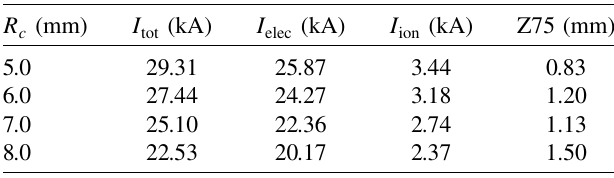
TABLE I. CRAD diode performance as a function of cathode inner